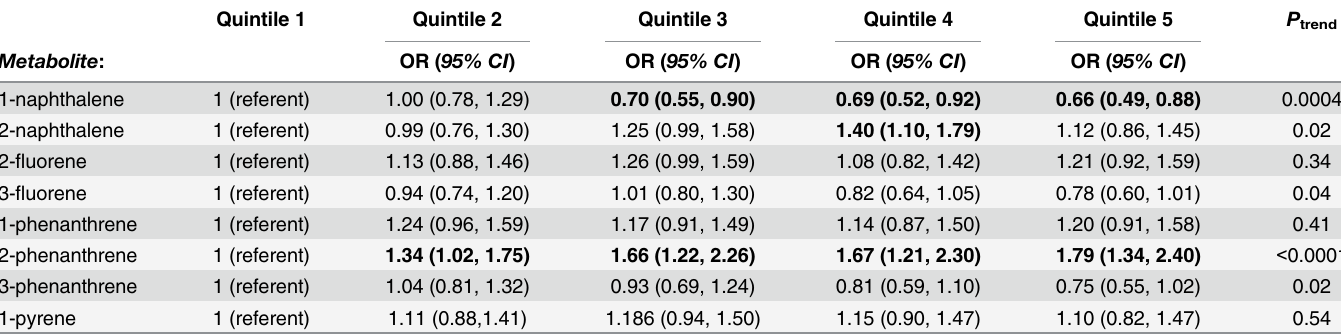
Table 2. Weighted and adjusted odds ratios for quintiles of PAH metabolites and obesity.